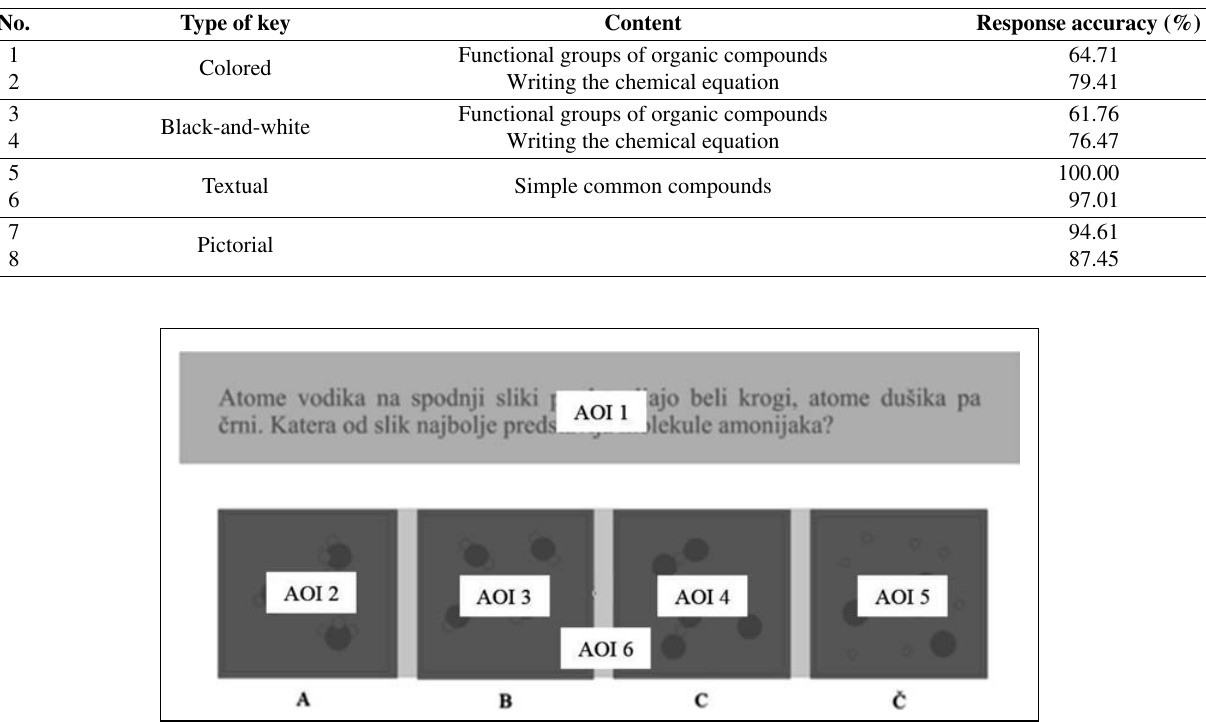
Table 1. Students’mean achievements